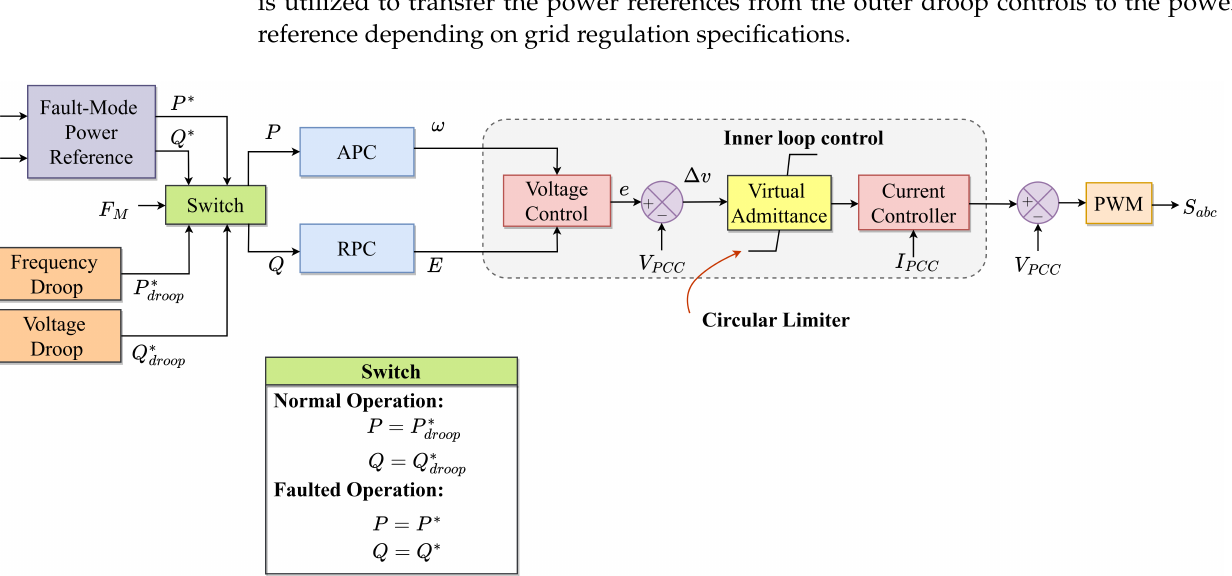
Figure 26. Proposed fault-mode control structure [126] (* indicated the reference